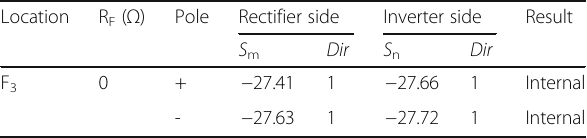
Table 4 Simulation results for a fault at F 4